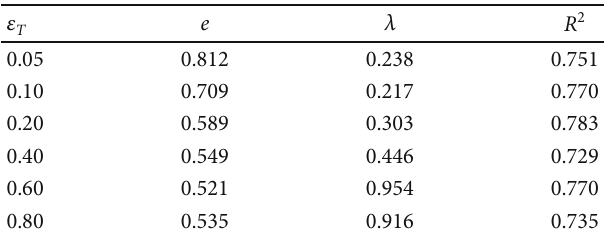
. Here, the starting time of stress relaxation was zeroed R Table 4: Parameters of the viscoelastic model for coarse-grained PU matrix at the di ff erent strains of stress